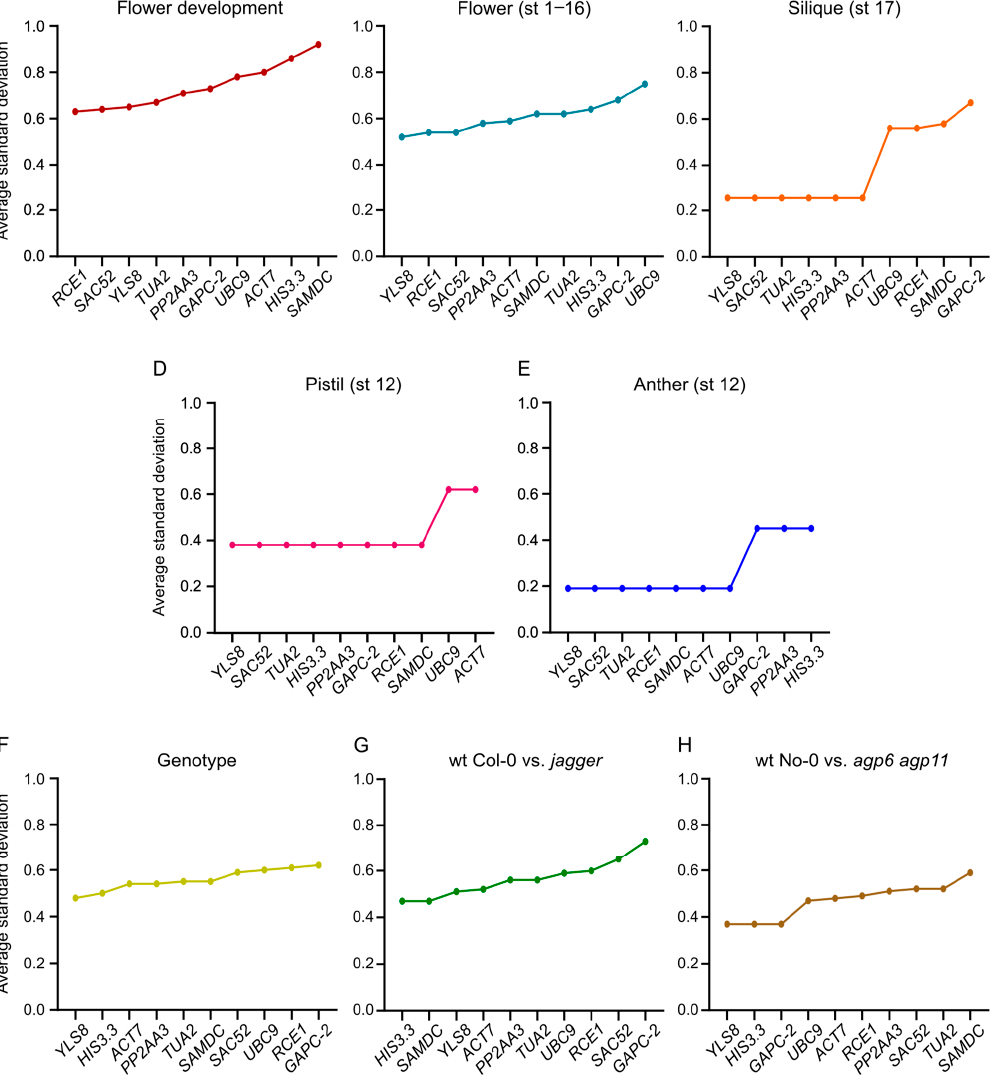
Figure 6. Average standard deviation (SD) of the ten candidate reference genes calculated by the Δ Ct in the RefFinder software. ( A ) SD values of the ten candidate reference genes in the flower development group which included 21 samples corresponding to flower (st 1–16), silique (st 17), pistil (st 12), and anther (st 12) samples. ( B ) SD values of the ten candidate reference genes in 12 flower (st 1–16) samples which included flower st 1–6, flower st 7–12, flower st 13–14, and flower st 15–16 samples. ( C ) SD values of the ten candidate reference genes in the three silique (st 17) samples. ( D ) SD values of the ten candidate reference genes in the three pistil (st 12) samples. ( E ) SD values of the ten candidate reference genes in the three anther (st 12) samples. ( F ) SD values of the ten candidate reference genes in the genotype set that comprised 12 samples corresponding to wt Col-0, jagger , wt No-0 and agp6 agp11 samples. ( G ) SD values of the ten candidate reference genes in six wt Col-0 vs. jagger samples that included three wt Col-0 and three jagger samples. ( H ) SD values of ten candidate reference genes in six wt No-0 vs. agp6 agp11 samples which included three wt No-0 and three agp6 agp11 samples. The genes are arranged from the most to the least stable gene (from left to right). Abbreviations: Col-0, Columbia-0; No-0, Nossen-0; st, stage; wt,